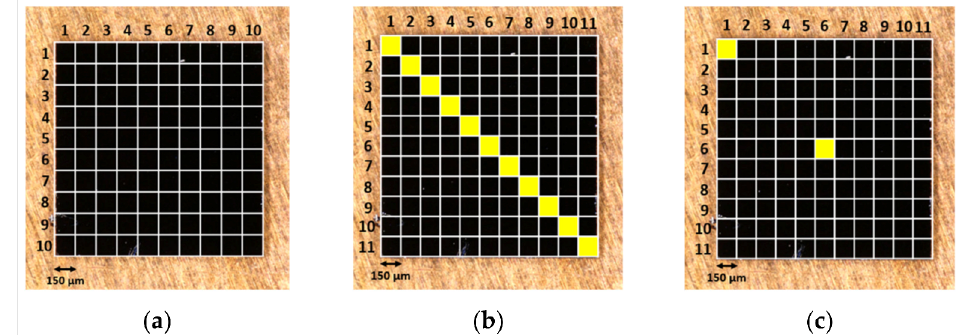
Figure 4. Schematic subdivision of the surface of silicon chips ( a ). The Raman signal is acquired at the center position of each square. The diagonal points [1, 1] to [11, 11] are colored yellow in panel ( b ), while the positions [1, 1] and [6, 6] are colored yellow in panel ( c ).